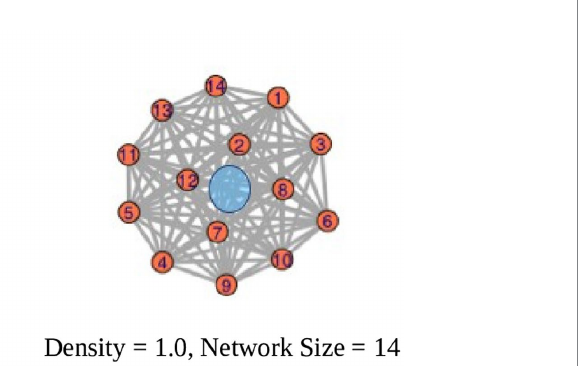
Supplementary Figure 5 for visual representations of different racial entropy scores.